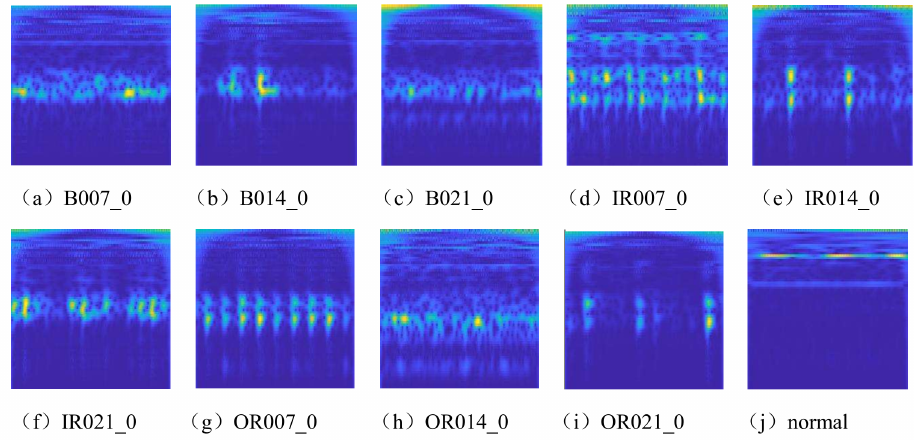
Figure 7. Wavelet transform images of different fault modes under load condition